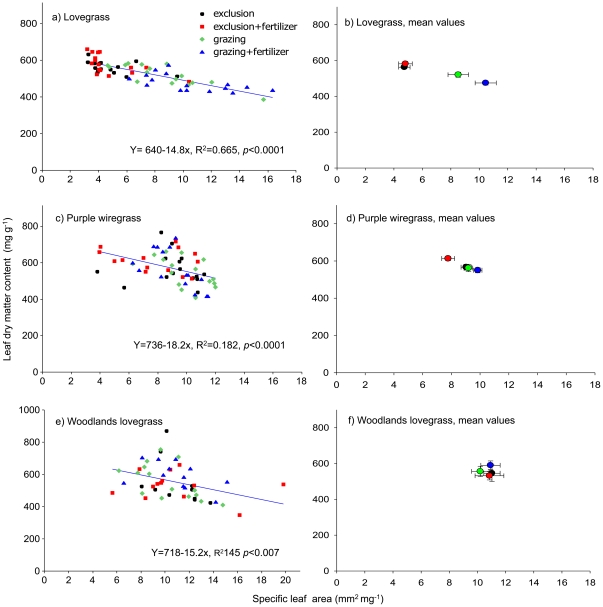
Correlations between LDMC and SLA values for each species depending on the four grazing and fertilizer treatments.Panel a), c) and e) show the mean LDMC and SLA values for each species collected from each plot and b), d), f) show the mean values for LDMC and SLA (±) for each treatment.